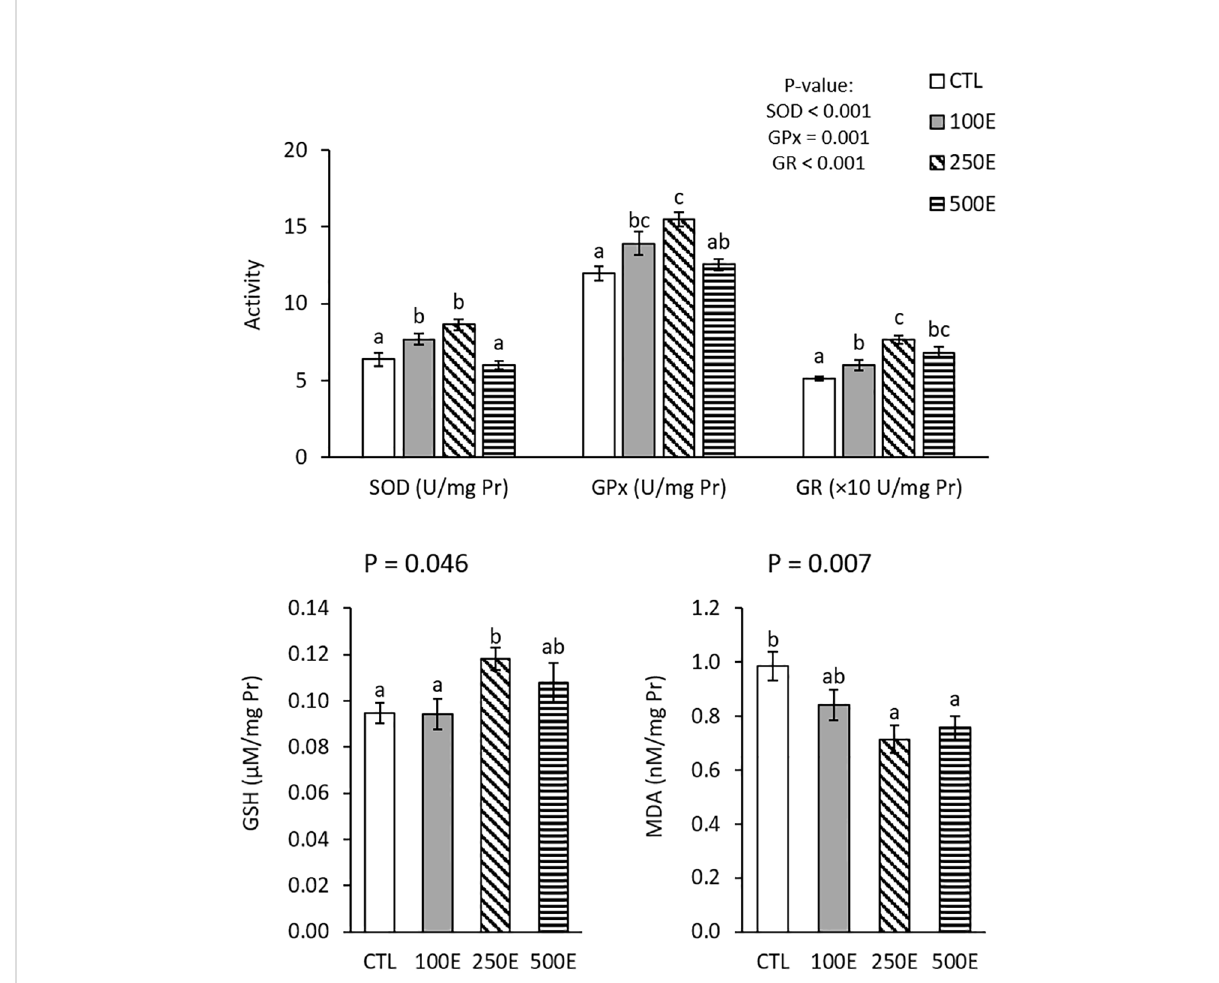
FIGURE 1 Hepatic antioxidant parameters (mean ± SE) of rainbow trout fed diets supplemented with 0-500 mg/kg HE over eight weeks. Different letters above the bars indicate signi fi cant differences among the treatments (Duncan test; n = 6).